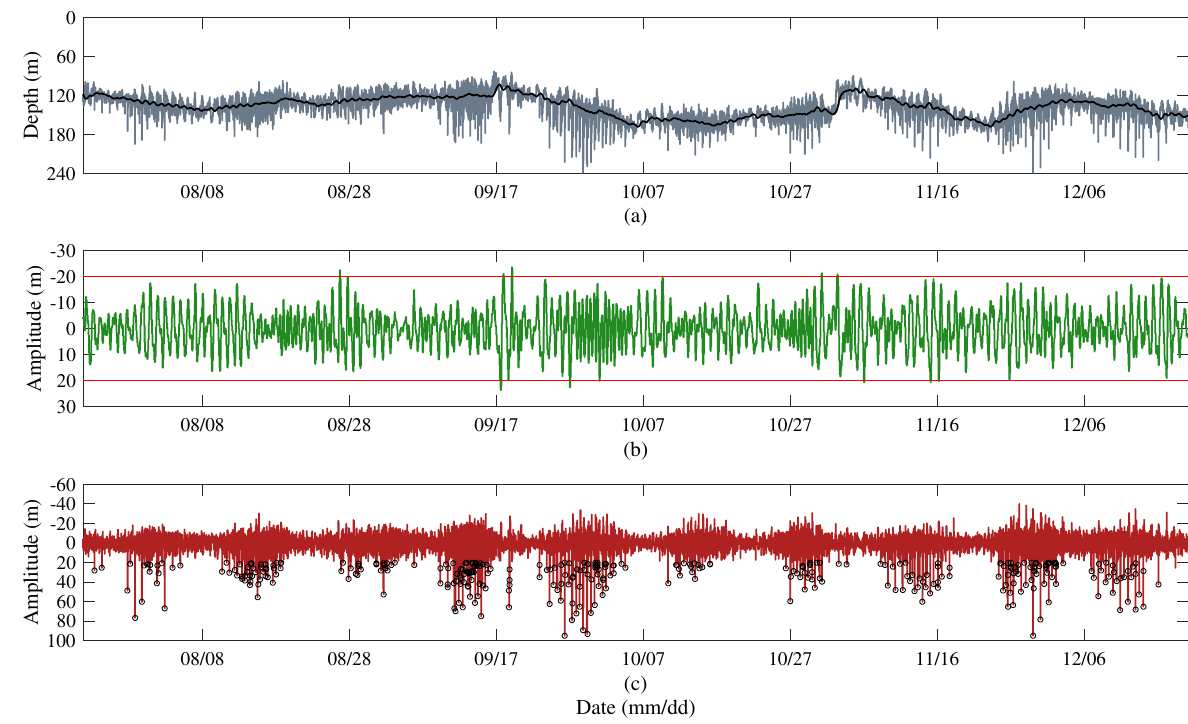
Figure 4. Schematic of identification of ISWs by SI method. ( a ) The 18 °C isotherm displacements (black) and the subtidal components (gray). ( b ) The internal tide components. The red lines are 20 m amplitudes. ( c ) The high frequency components. The downward spike-like fluctuations (small black circles) are the large amplitude ISWs. The frequency limits of ( a–c ) are 0.4 cpd, 0.4–2.5 cpd and 2.5 cpd, respectively.